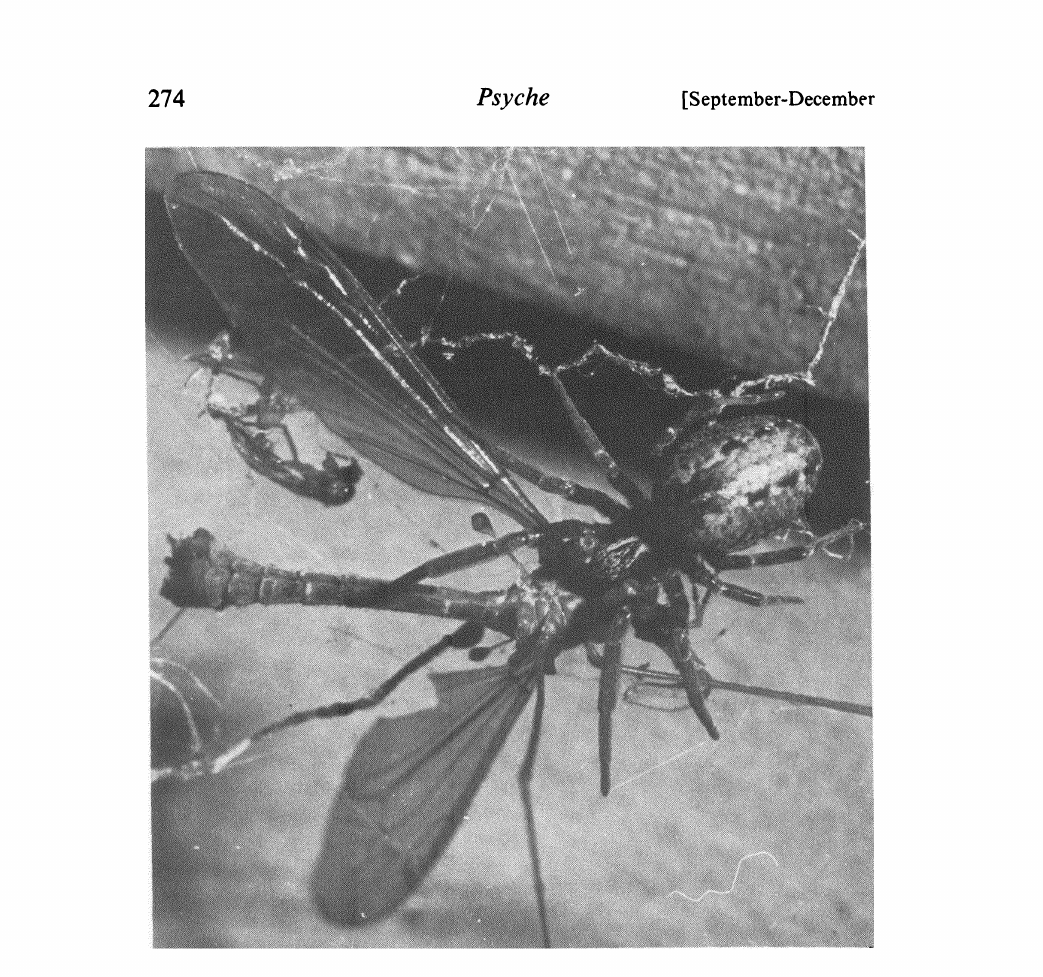
Fig. 1. Adult female Mallos trivittatus (body length: 7 mm) at East Turkey Creek (Chiracahua Mountains, Arizona) feeding on tipulid fly. Fly grasped at ventral